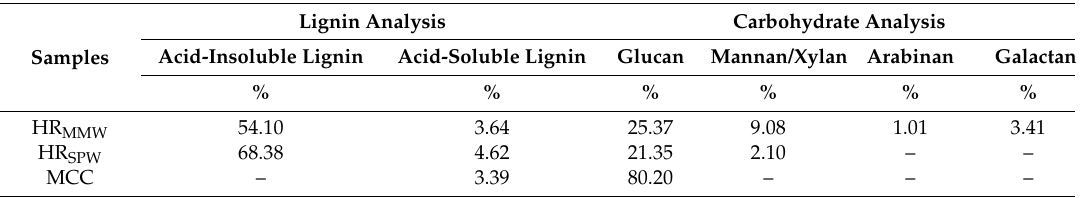
Table 1. Chemical compositions of hydrolyzed residuals and microcrystalline cellulose (MCC). Samples